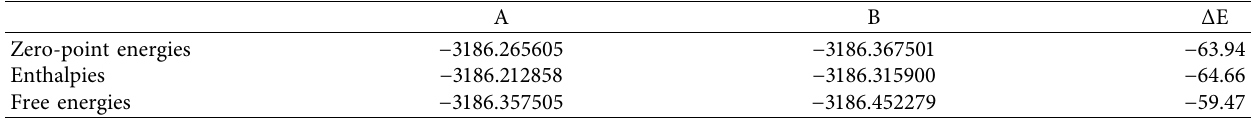
Figure 1: Te two conformations of the IGC molecule. Table 1: Te absolute and relative energies of the two conformations of the IGC molecule 1